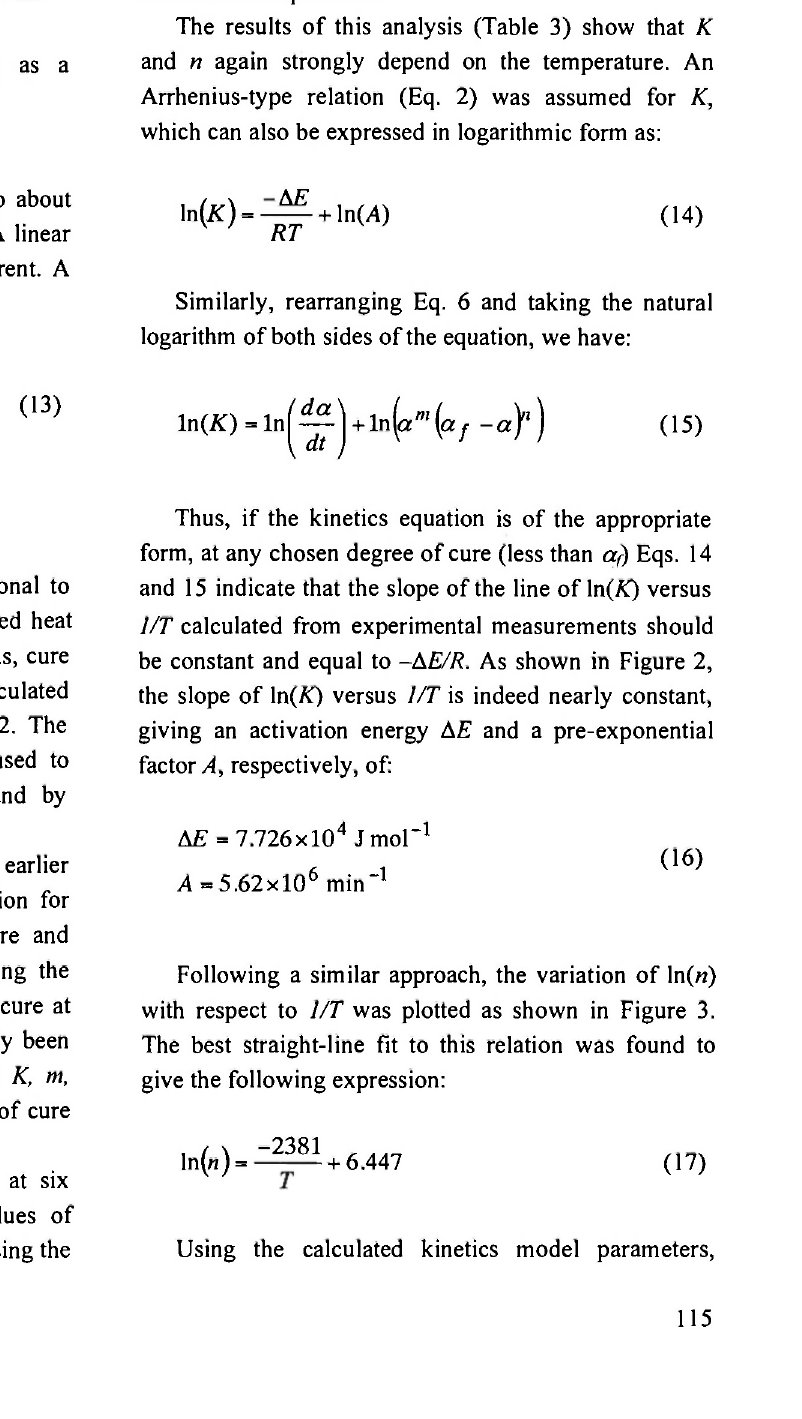
Fig. 1: Maximum accessible degree of cure as a function of inverse absolute